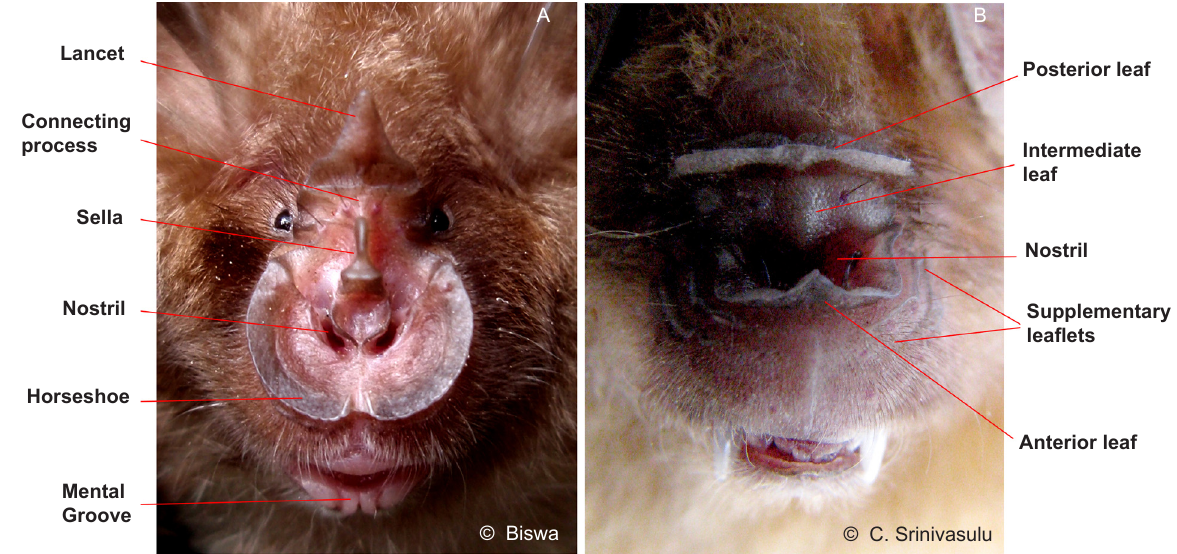
Figure 9. Frontal view of noseleaf of a rhinolophid [a] and a hipposiderid [B]